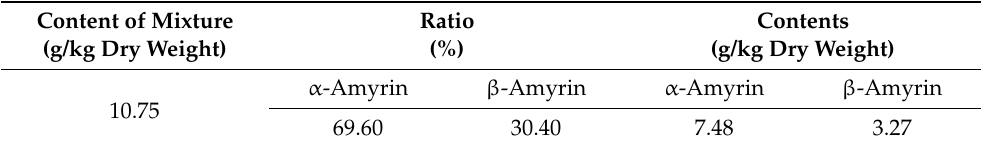
Table 3. Quantification of α -amyrin and β -amyrin in C. hindsii leaves. Content of Mixture